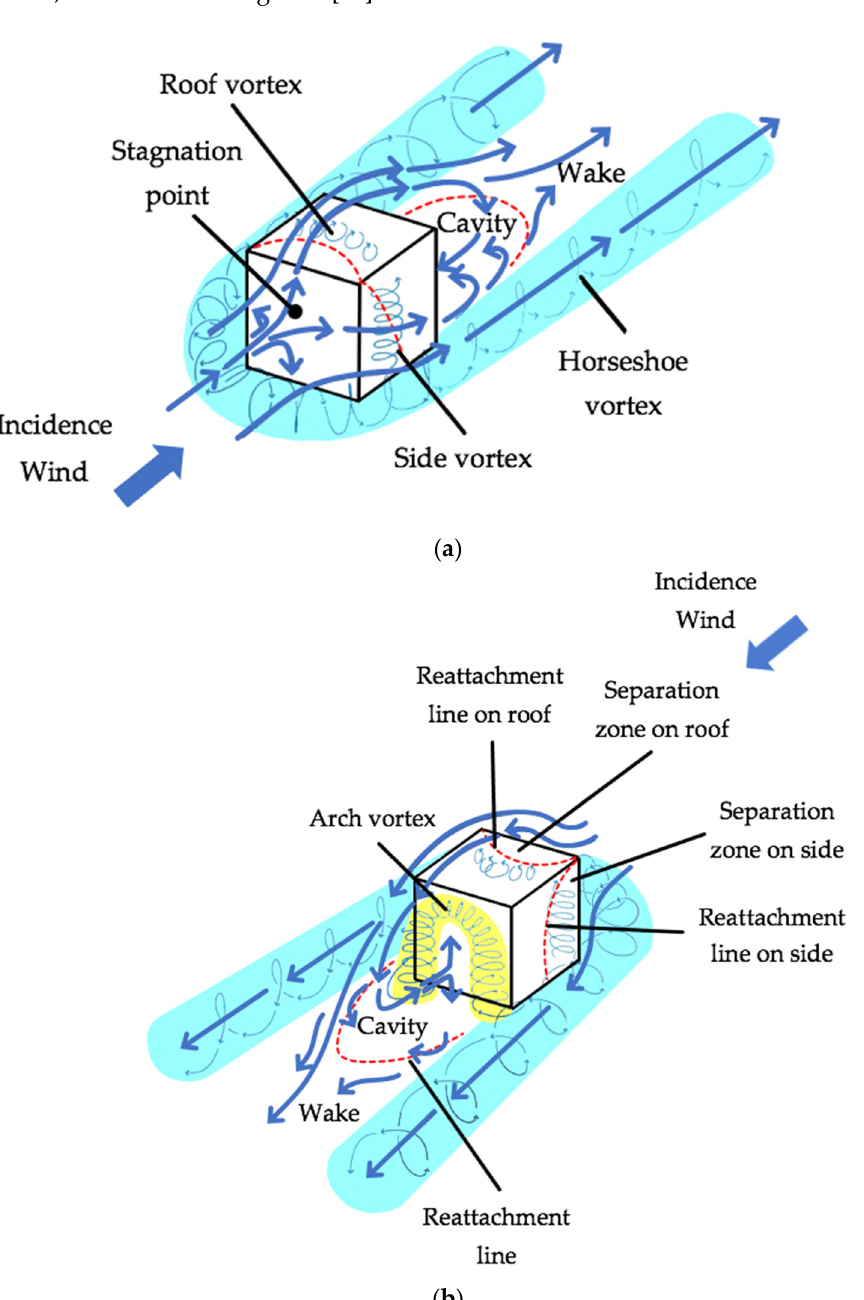
Figure 3. Schematic airflow patterns around an isolated cubical building with wind incidence angle perpendicular to the building ( a ) windward view, and ( b ) leeward view (modified from Oke et al. [19] and Blocken et al.